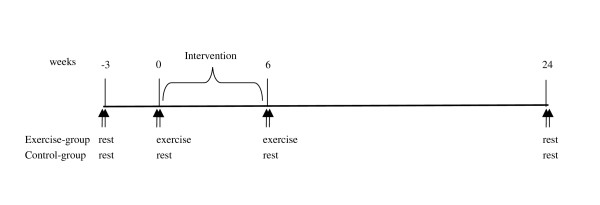
Study design. Blood-sampling procedures during the study from study baseline at -3 weeks to the end of the study at 24 weeks. Blood samples were obtained before and after 60 minutes exercise/rest at each occasion. The arrows indicates blood-sampling occasions. Two blood-samples at each occasions, with an hour apart.